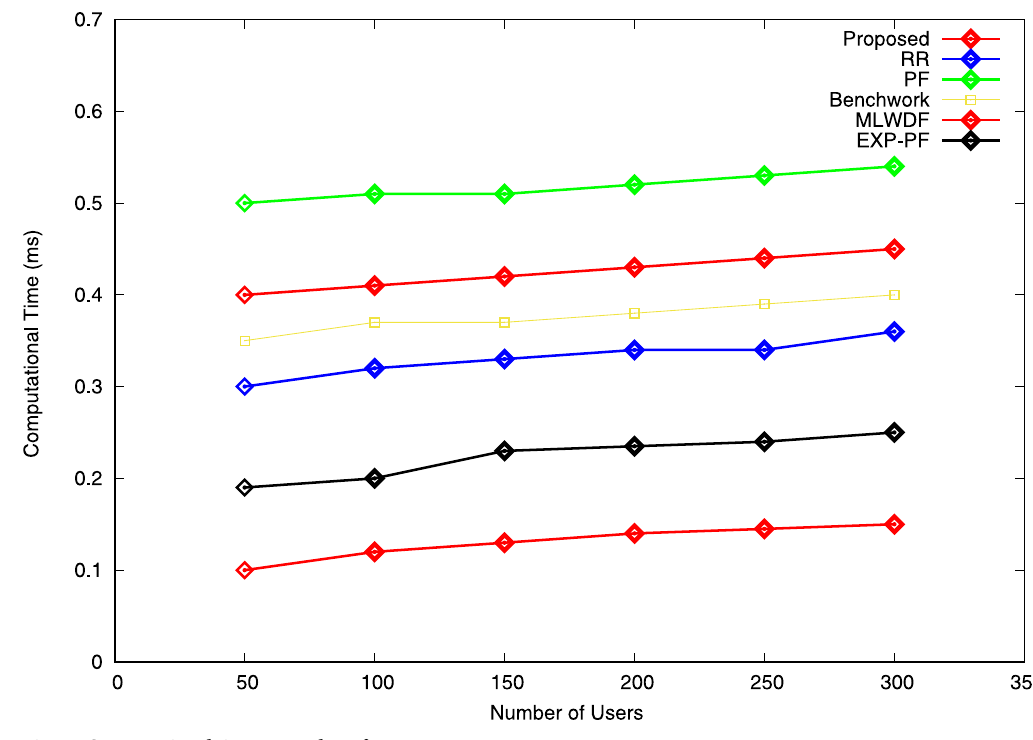
Fig 13. Computational time vs number of